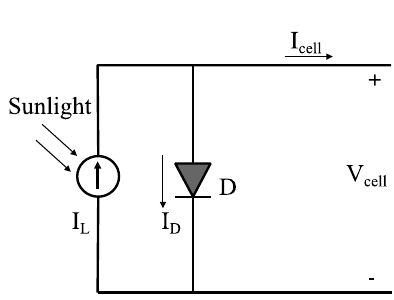
Figure 1. Ideal circuit model of a photovoltaic cell.